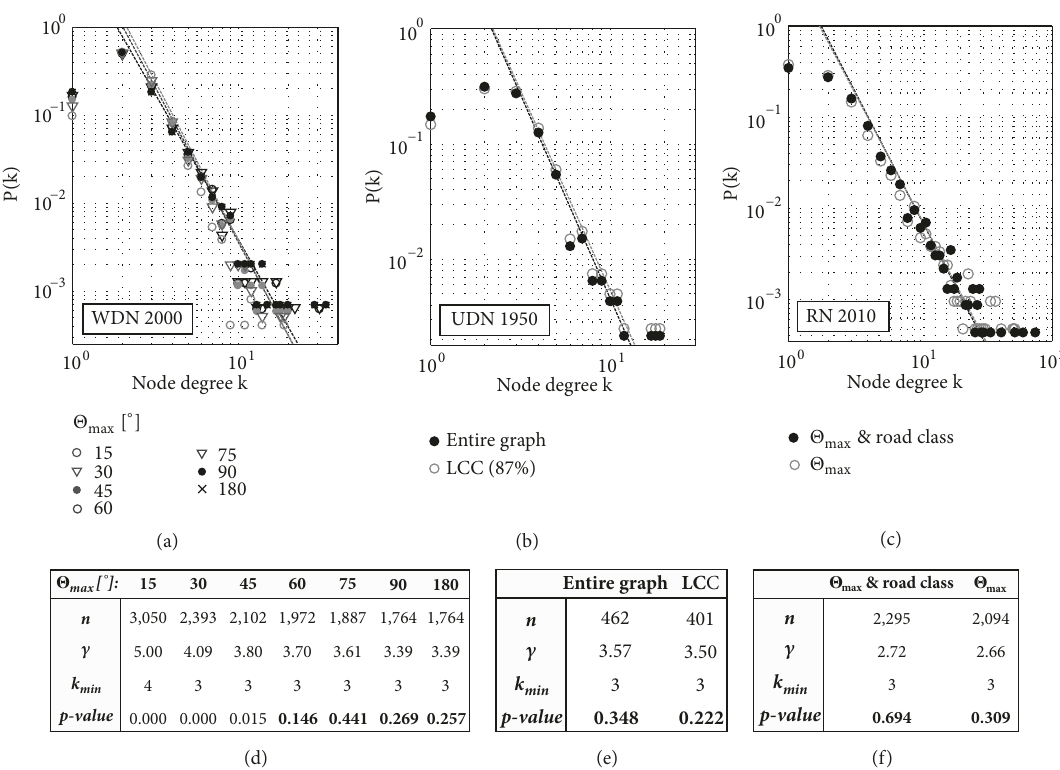
Figure 4: Parameter sensitivity of the HICN approach on the node degree distribution of the WDN 2000; the UDN 1950 and the RN 2010 ( 𝑛 : number of dual nodes, 𝛾 : power-law exponent, 𝑘 𝑚𝑖𝑛 : lower bound to the power-law behavior, p value: goodness-of-fit for the power-law